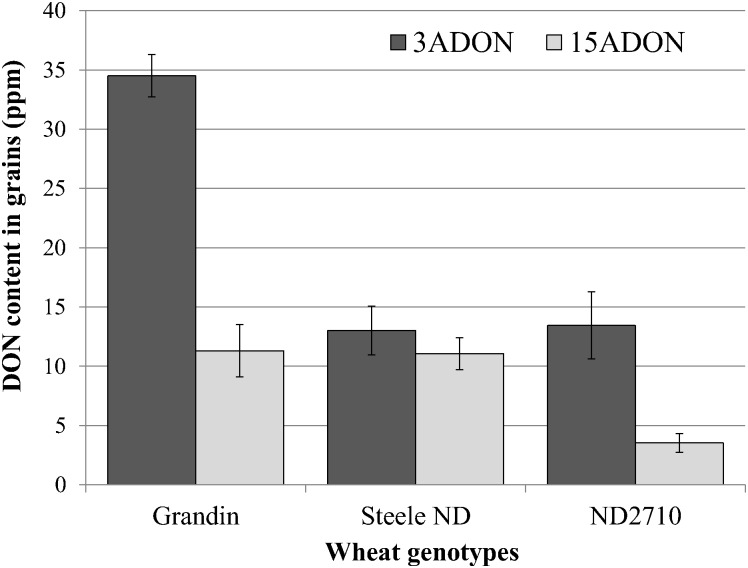
Total amount of deoxynivalenol (DON) accumulated on wheat grains.DON was obtained from spikes of three wheat genotypes (Grandin, Steele-ND, and ND 2710) after inoculations with 3ADON and 15ADON isolates, respectively. The 3ADON population accumulated a significantly higher DON on Grandin (p < .0001) and ND 2710 (p = 0.0034) than the 15ADON population. However, no significant difference (p = 0.4366) in DON accumulation on Steele ND was found between the two populations.